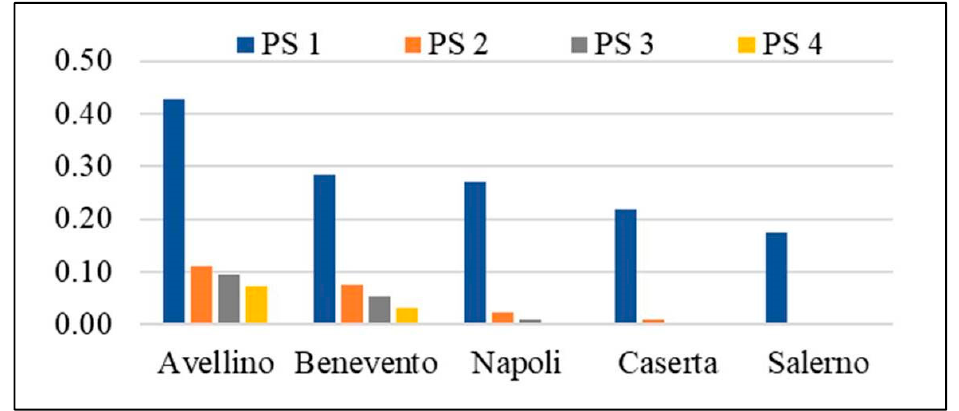
Figure 15. 4-storey building Campania region: combined structural and energetic index.